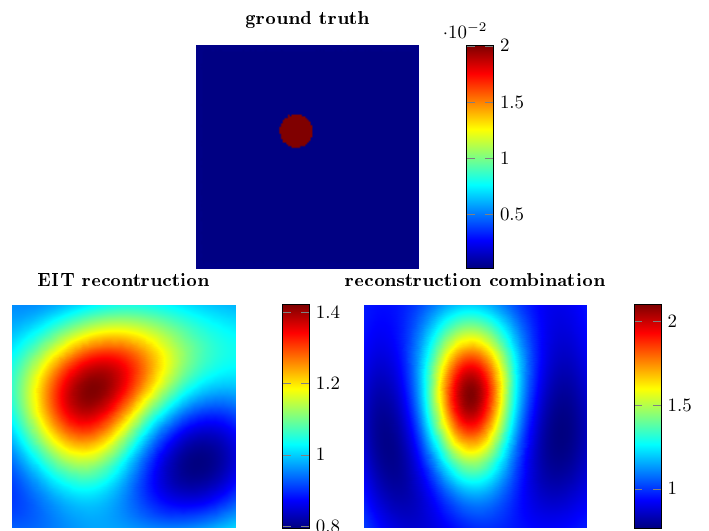
Figure 10. Top: Ground truth of the conductivity enclosure. Bottom left: EIT reconstruction with 0.75% noise added and R 1 = 3. Bottom right: Combination of noisy EIT data (0.75% noise) and radar data. R 1 = 3 and R 2 = 4. The noise was added to the voltages of the electrodes in percentage of the peak-to-peak value.